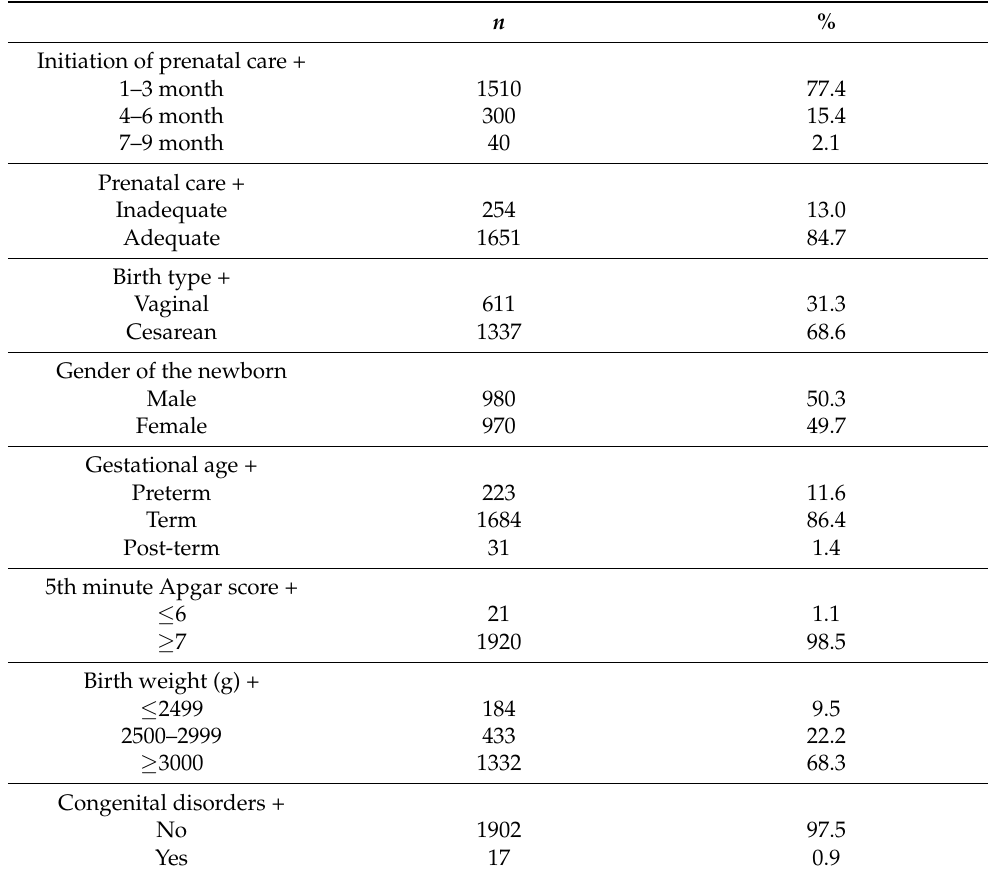
Table 3. Maternal and neonatal outcomes and pre-natal assistance in cities in a coal mining area, Brazil.